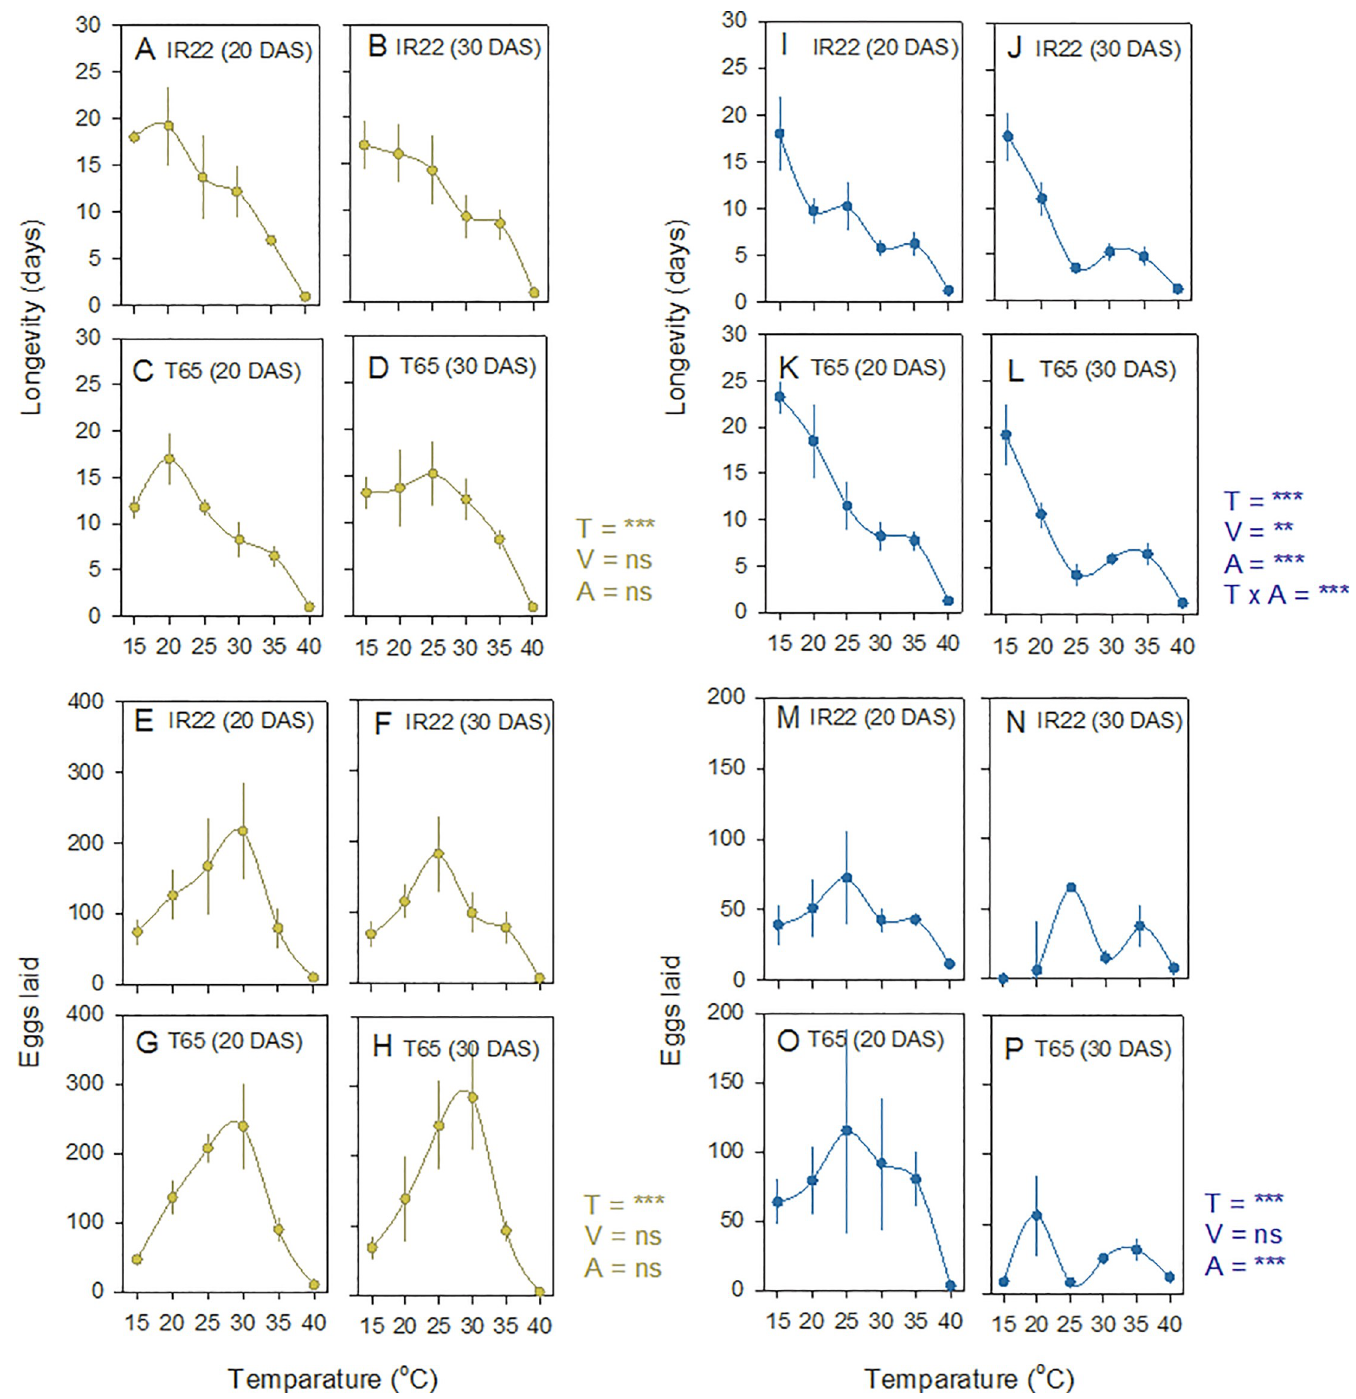
Fig 3. Adult female longevity and egg-laying by BPH (brown symbols: A-H) and WBPH (blue symbols: I-P). Planthoppers were maintained on indica (IR22: A,B,E, F,I,J,M,N) and japonica (T65: C,D,G,H,K,L,O,P) rice varieties initially infested at 20 DAS (A,C,E,G,I,K,M,O) and 30 DAS (B,D,F,H,J,L,N,P) across a gradient of temperatures. The times to 0% survival of adult females are indicated in A-D and I-L. The total numbers of eggs laid are indicated in E-H and M-P. Numbers are based on accumulated data over 20 days of the experiments. Bars indicate standard errors (N = 4). The effects of temperature (T), variety (V), and plant age (A) and significant interactions are indicated as ns (P > 0.05), �� (P � 0.01), and ��� (P � 0.001). See also Table 3.